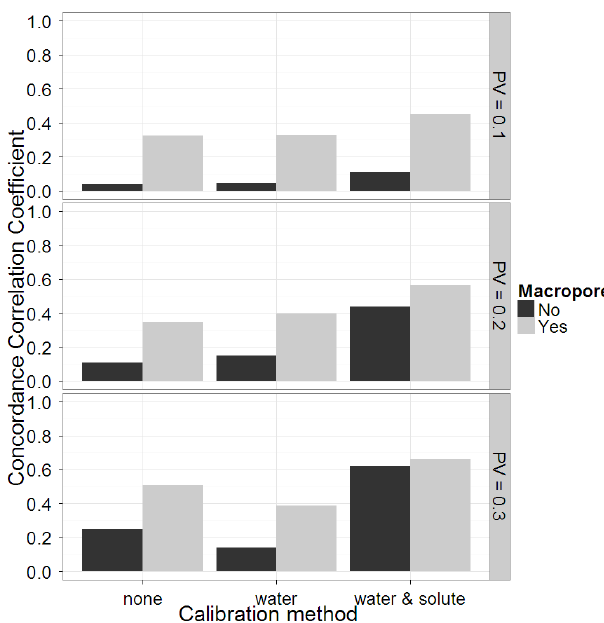
Fig. 6. Concordance correlation coefficient of the measured ver- sus simulated soil ranks according to the accumulated solute loads leached at 0.1, 0.2 and 0.3 pore volumes for different calibration methods: no calibration (only pedotransfer functions); after cali- bration of 2 water-related crop parameters; after calibration of 2 additional solute-related crop and soil parameters. Darker bars rep- resent simulations where solute macropore flow has been switched- off, and grey bars represent (standard) simulations where macropore flow parameters were set according to the pedotransfer functions. Some soil profiles are not included in the CCC calculation at